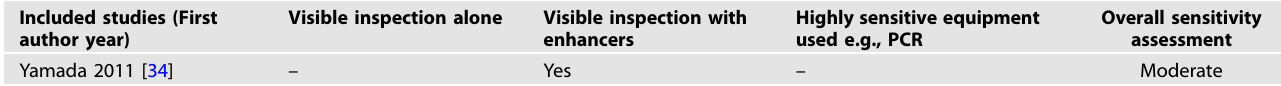
Table 7. Sensitivity measure of studies used blood to measure contamination (non-microbial / non-blood based) ( n = 1). Included studies (First author